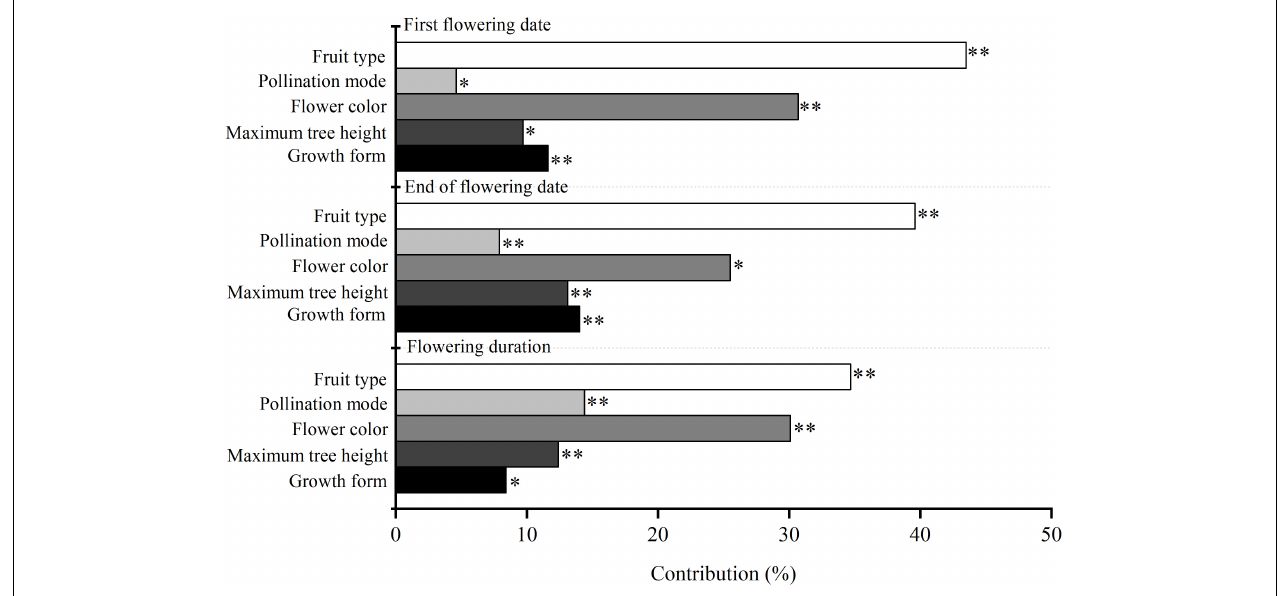
FIGURE 1 | The independent contribution of plant functional traits (i.e., maximum plant height, flower color, fruit type, and pollination mode) and growth form (i.e., tree and shrub) to three characteristics of flowering phenology. ∗∗ and ∗ are the confidence coefficient of the functional traits to its corresponding flowering phenology in the hierarchical partitioning analysis. ∗∗ P < 0.01; ∗ P < 0.05.